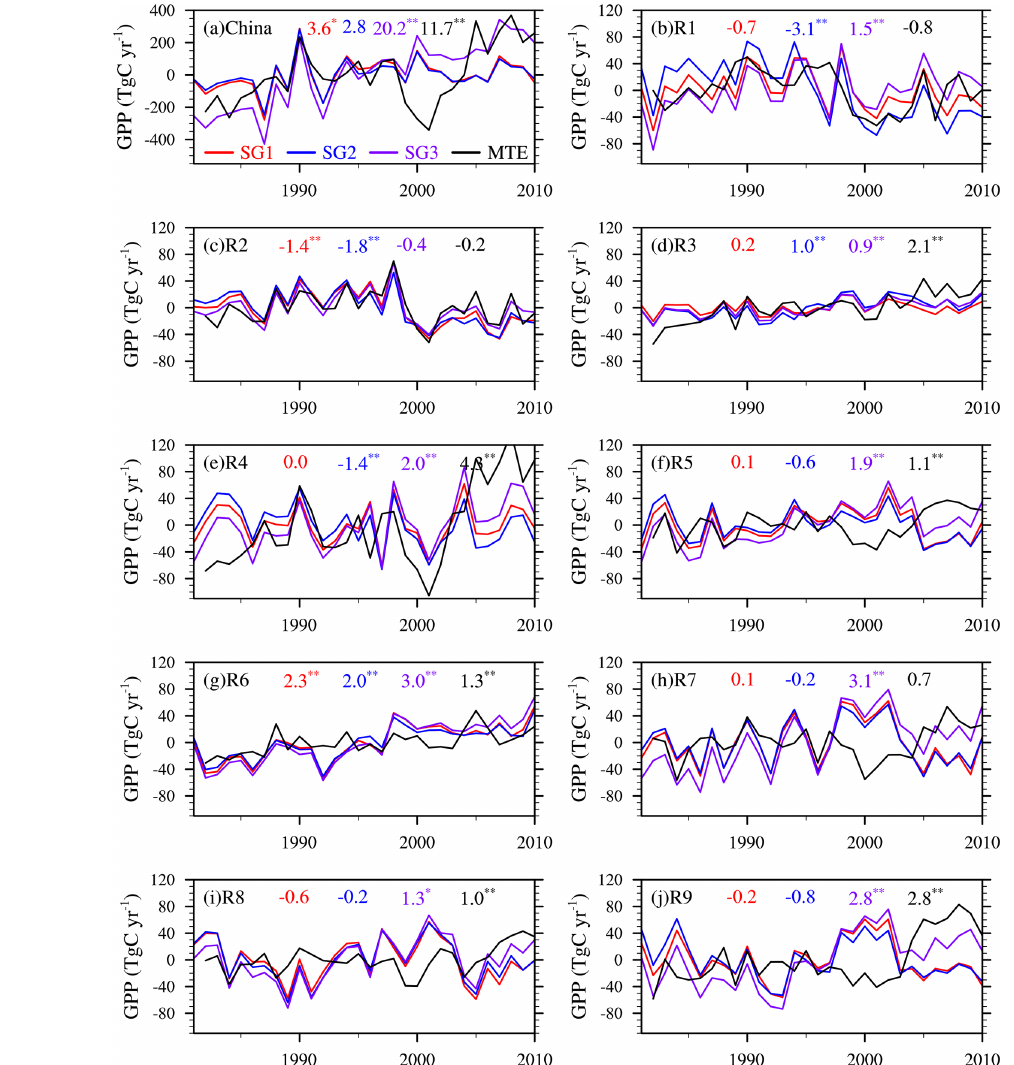
Figure 4. Interannual variations in GPP of China and each subregion from the MTE (black) and the ensemble mean of the 12 MsTMIP models: SG1 (blue), SG2 (red), SG3 (purple). The anomalies of GPP were calculated as the difference between annual GPP and the long- term mean between 1981 and 2010 (MTE is 1982–2010). The numbers located at the top of each figure indicate the linear trends of SG1 (blue), SG2 (red), SG3 (purple) and MTE (black) with units of TgCyr − 2 (1TgC = 0.001PgC). Single ( ∗ ) and double ( ∗∗ ) asterisks indicate that the trend is significant with p < 0 . 1 and p < 0 . 05,